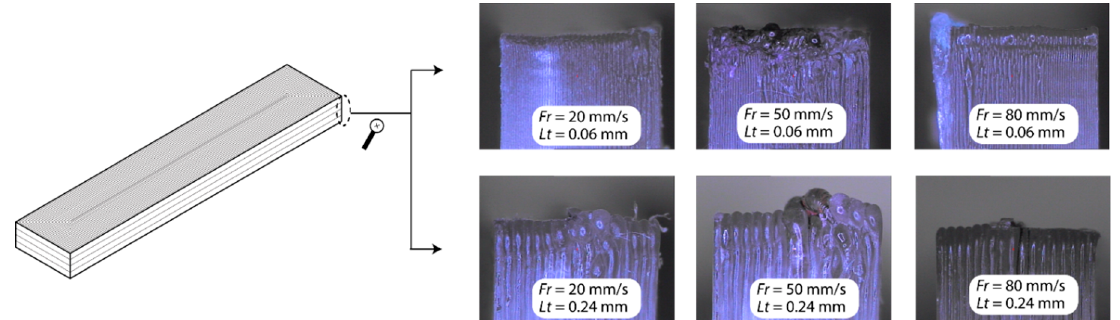
Figure 4. Malformation produced in the cured layer in the flat orientation.